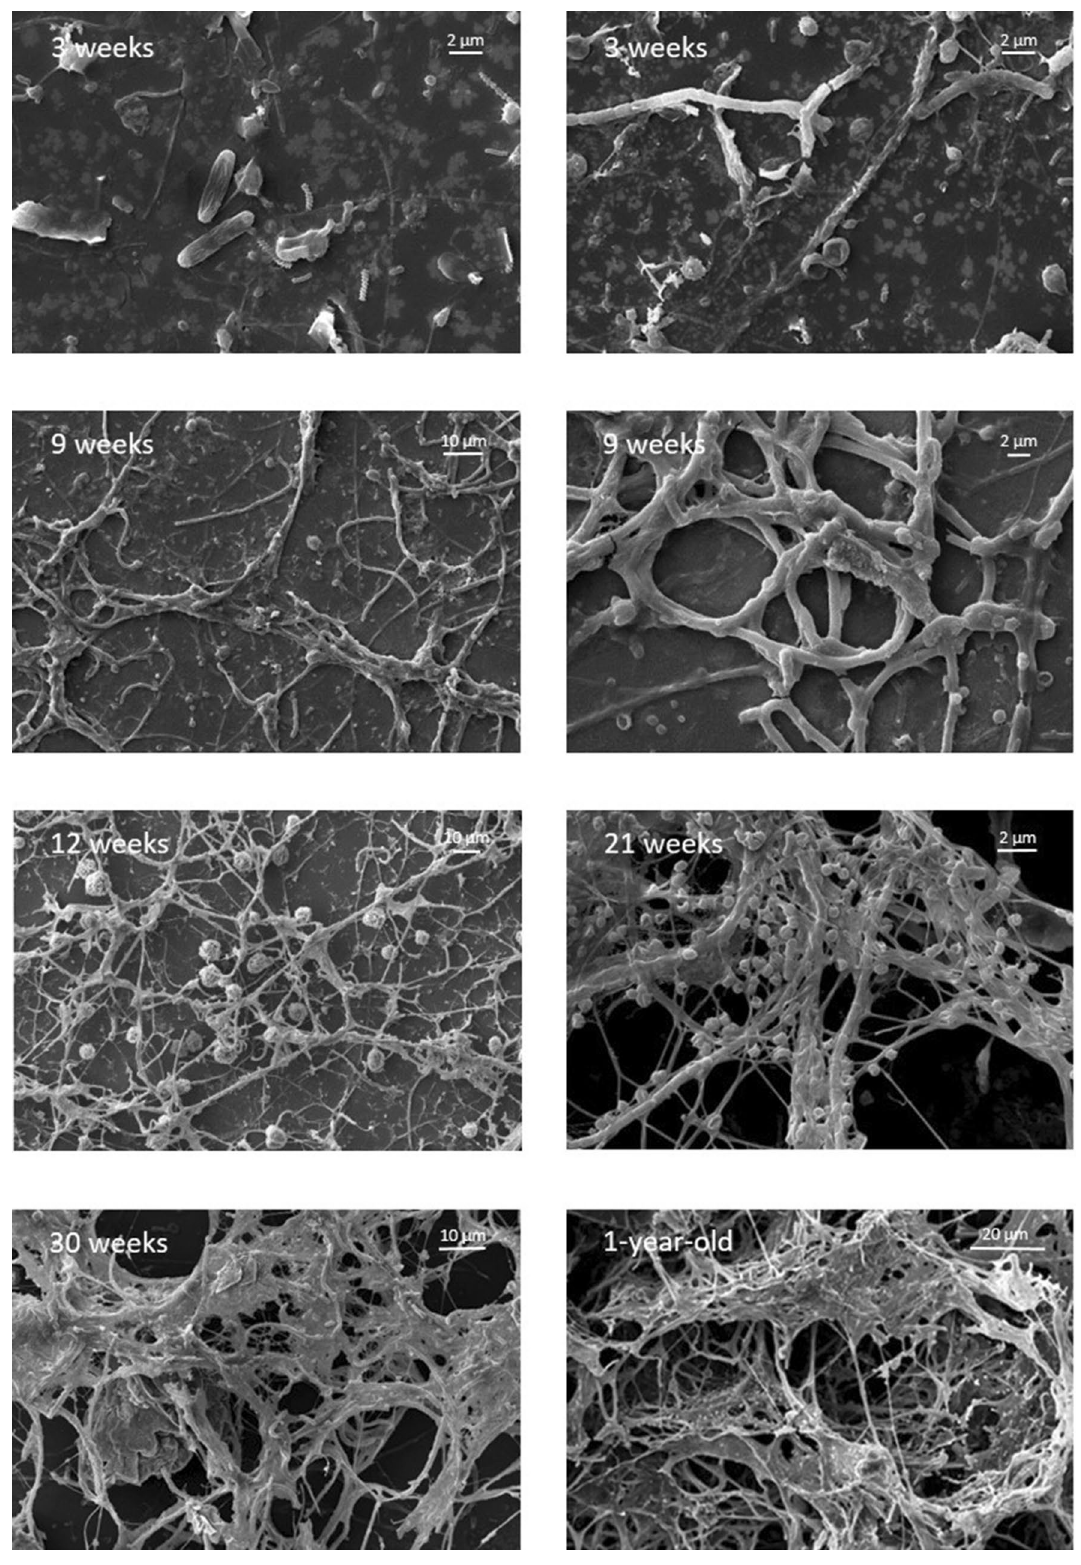
Figure 2. SEM micrographs of biofilm samples developing on the glass slides during a one year period (3 weeks ( A , B ), 9 weeks ( C , D ), 12 weeks ( E ), 21 weeks ( F ), 30 weeks ( G ), 1-year-old biofilm ( H )) in the RT thermal spring. Scale bar ( A,B,D,F ) 2 µm, ( C,E,G ) 10 µm, ( H ) 20